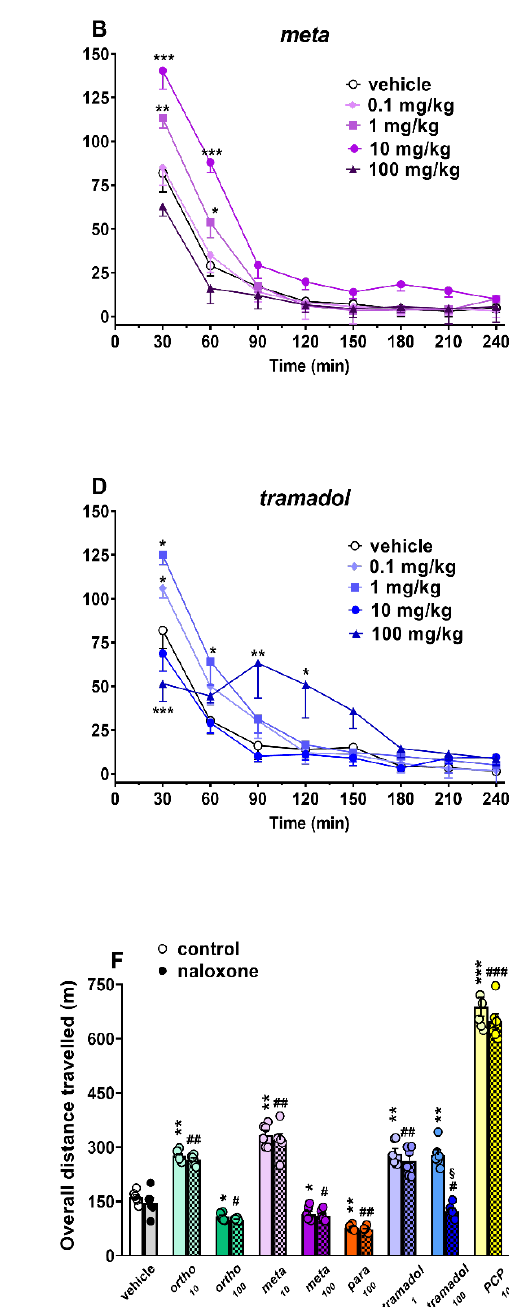
Figure 10. Effects of the systemic administration (0.1–100 mg/kg i.p.) of ortho ( A ), meta ( B ), para ( C ) and tramadol ( D ) on the total distance travelled of the mouse. Representation of the effect induced by ortho, meta, para, tramadol (0.1–100 mg/kg) and PCP (0.01–10 mg/kg) treatments on the overall distance traveled observed in 4 h ( E ) 2 . Interaction of the effective doses of ortho (10 and 100 mg/kg), meta (10 and 100 mg/kg), para (100 mg/kg), tramadol (1 and 100 mg/kg) and PCP (10 mg/kg) with the opioid receptor antagonist naloxone (6 mg/kg, i.p.; ( F )). Data are expressed as meters travelled (total distance travelled) and represent the mean ± SEM of 8 determinations for each treatment. Statistical analysis was performed by two-way ANOVA, followed by Bonferroni’s test for multiple comparisons of the dose–response curve of each compound at different times ( A – D ), and for the antagonist studies ( F ), while the statistical analysis of panel E was performed with one-way ANOVA followed by Bonferroni test for multiple comparisons. * p < 0.05, ** p < 0.01, *** p < 0.001 versus vehicle; a p < 0.05 versus tramadol; b p < 0.05 versus PCP; c p < 0.05 versus ortho; d p < 0.05 versus meta; e p < 0.05 versus para; # p < 0.05, ## p < 0.01, ### p < 0.001 versus naloxone; § p < 0.05 versus without naloxone. 2 PCP data are elaborated from [17].